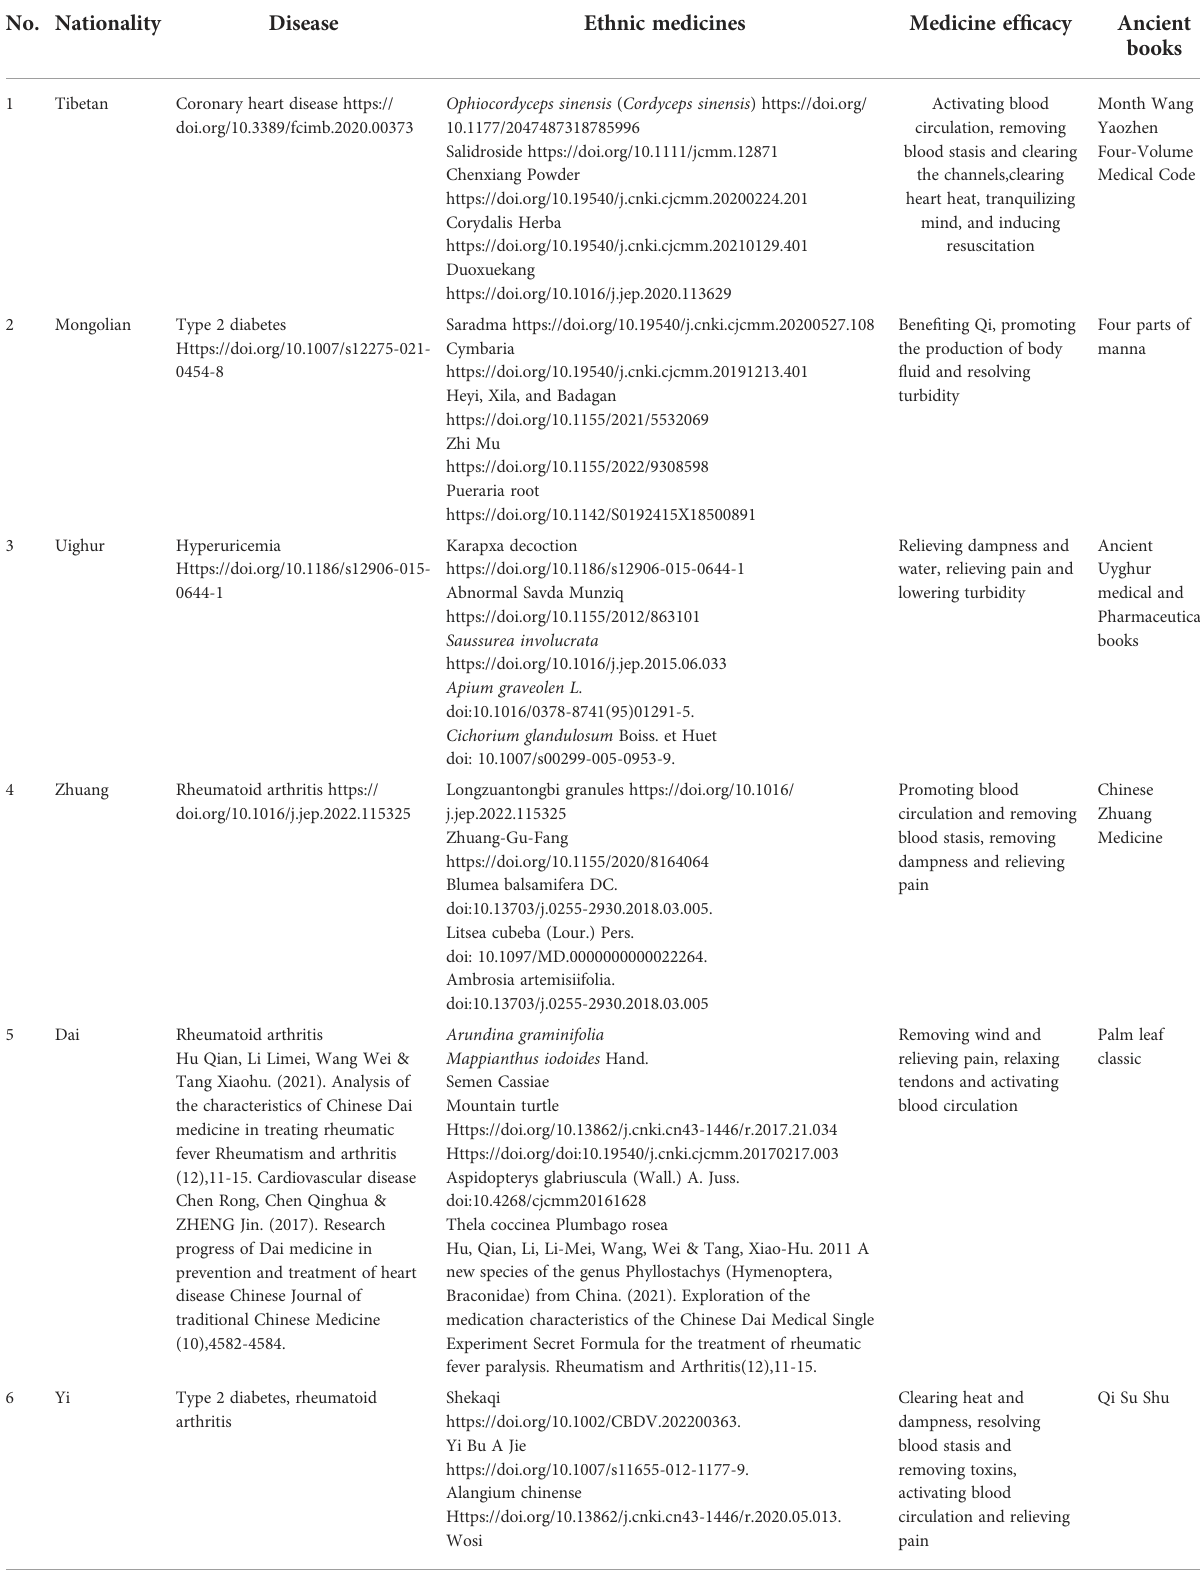
TABLE 2 Collection of common ethnic diseases and ethnic medicines recorded in the literature (partial